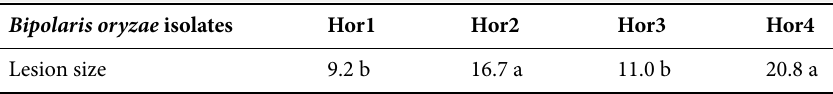
Table 3 e degree of lesion on Typha latifolia leaves at 7 days aer inoculation with the mycelial discs of each isolate of Bipolaris oryzae